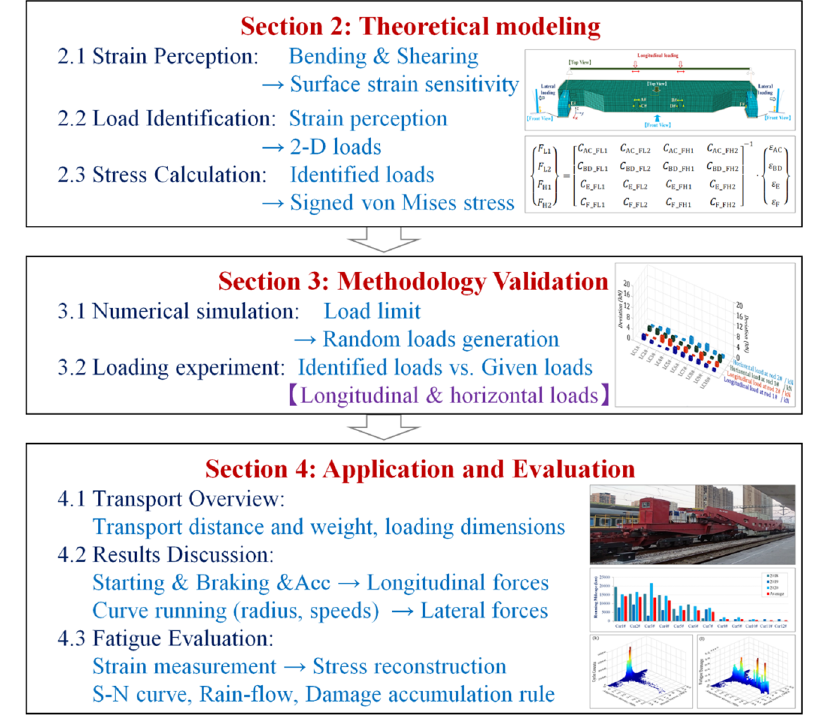
Figure 2: The framework of this